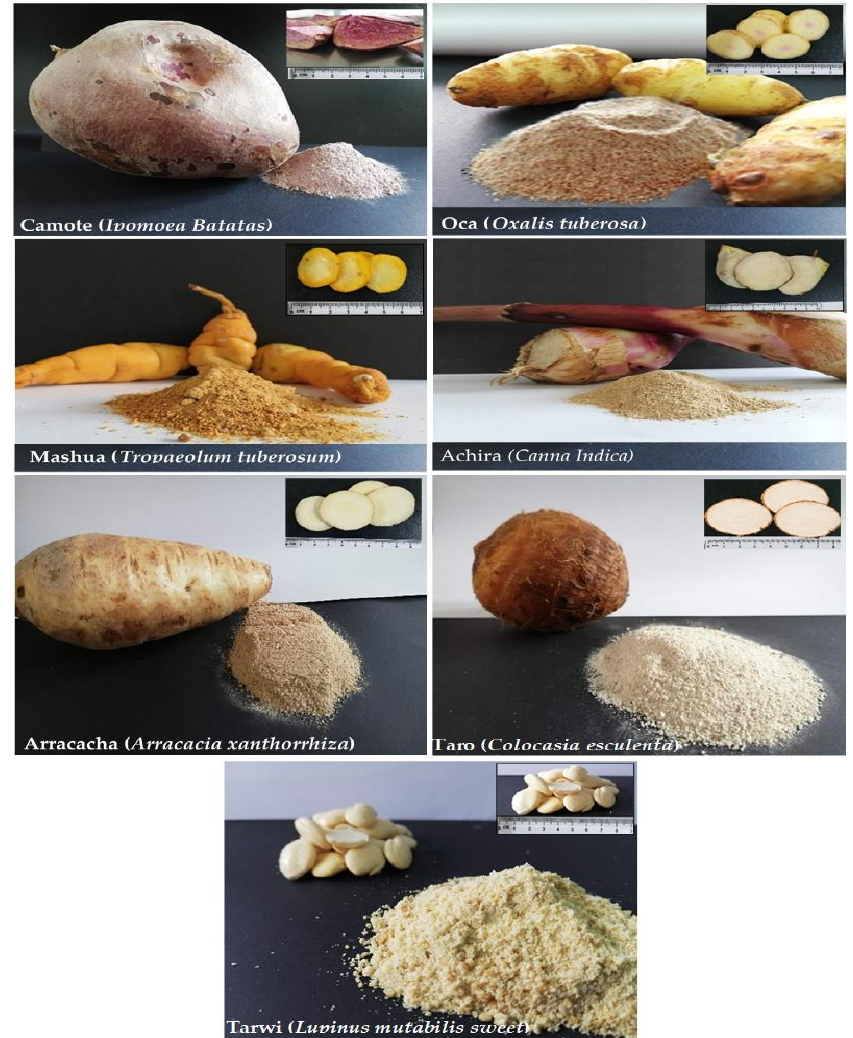
Figure 1. Visual appearance of the Ecuadorian Andean crops and their corresponding flour pro-